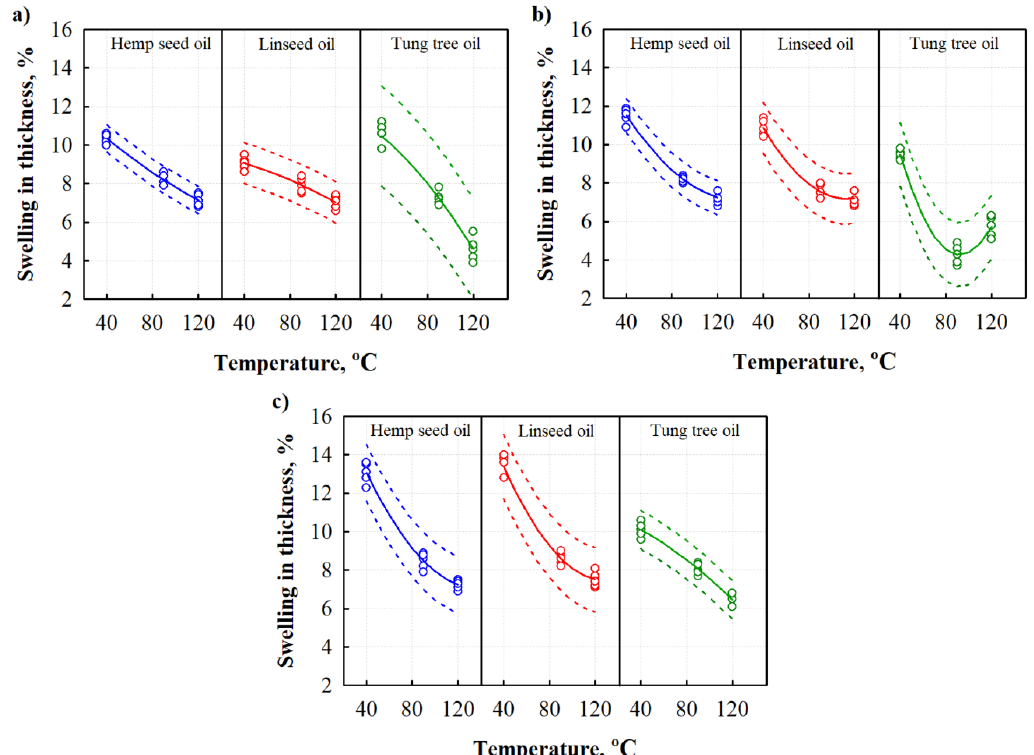
Figure 3. Dependences of swelling in thickness on hardening temperature of different oils- impregnated BcBs: ( a ) F composition; ( b ) G composition; and ( c ) H composition. BcBs: ( a ) F composition; ( b ) G composition; and ( c ) H